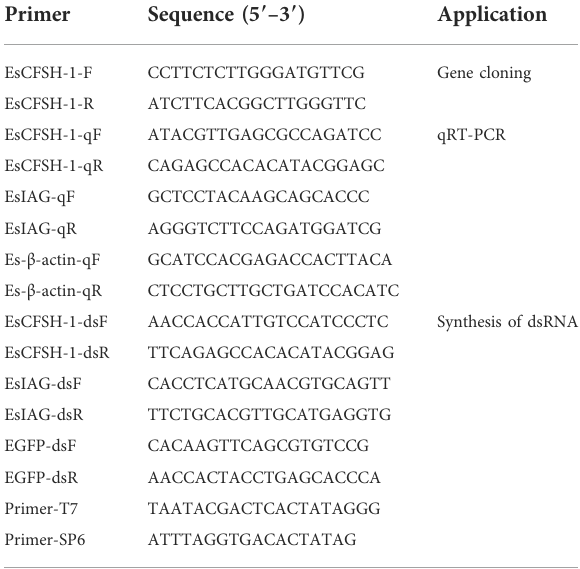
TABLE 1 The summary of primers used in this